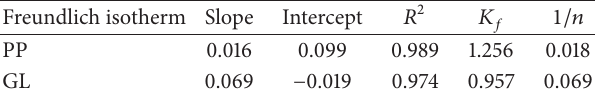
Figure 16: Temkin isotherm model. Table 8: Adsorption isothermal parameters of Temkin isotherm.